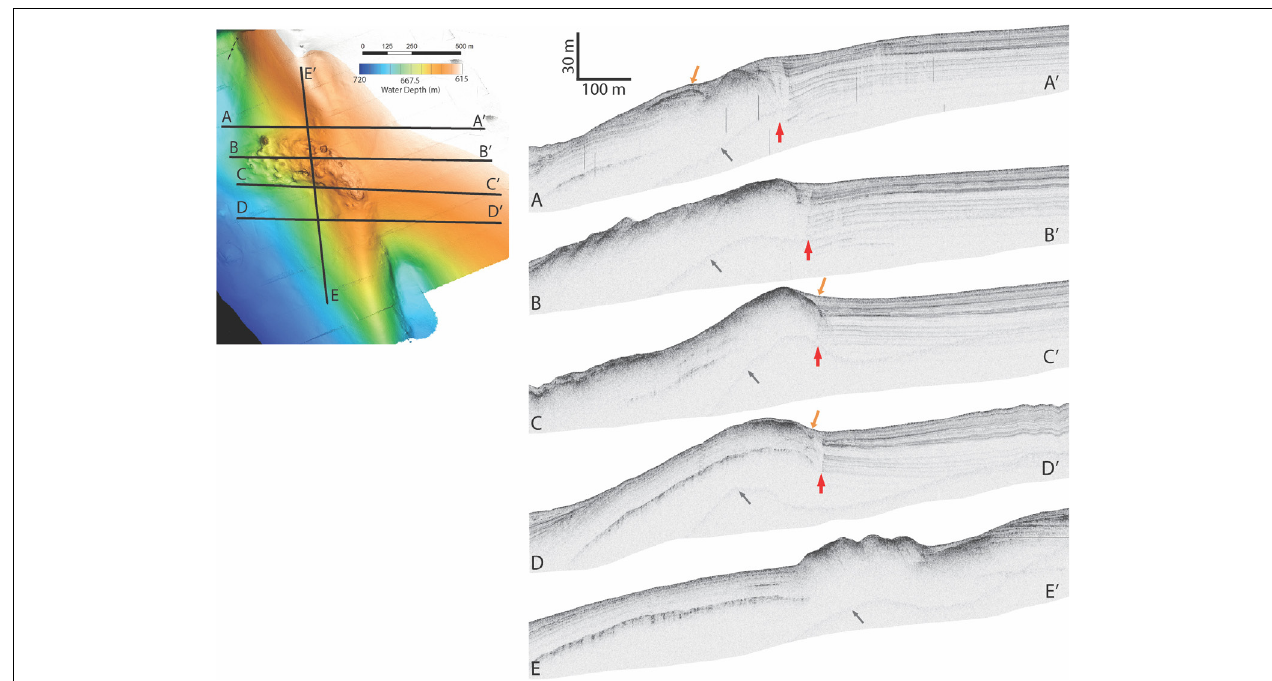
FIGURE 2 | Chirp profiles taken across the Fossil Hill main mound structure. Colored insert shows the locations of the paths of profiles A–A’ , B–B’ , C–C’ , D–D’ , E–E’ . The locations of recent fault offsets (red arrows), sediment drape covering or lapping onto the mound (orange arrows), and artifacts associated with a multiple reflection off the sea surface (gray arrows) are shown.